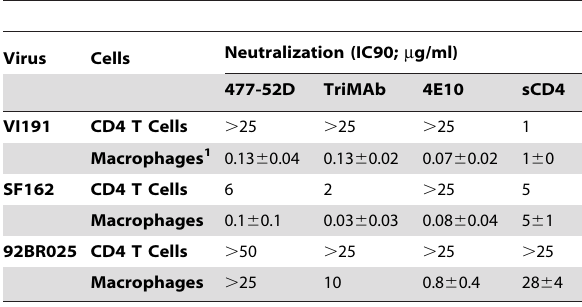
Table 5. Comparisons of Intracellular p24 assay performed with CD4 + T cells and